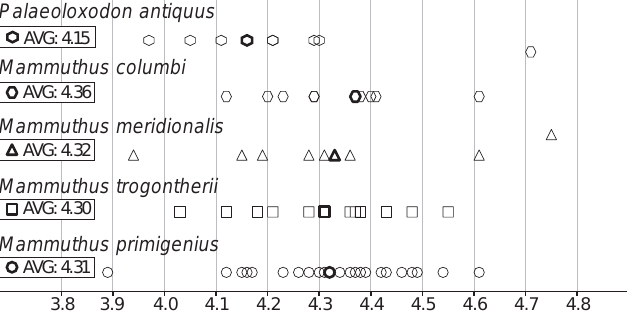
Fig. 7. Tibia length vs. skeletal shoulder height ratio of selected probosci- deans based on the data collected in this study (Appendix 1, SOM: table 2; AL unpublished